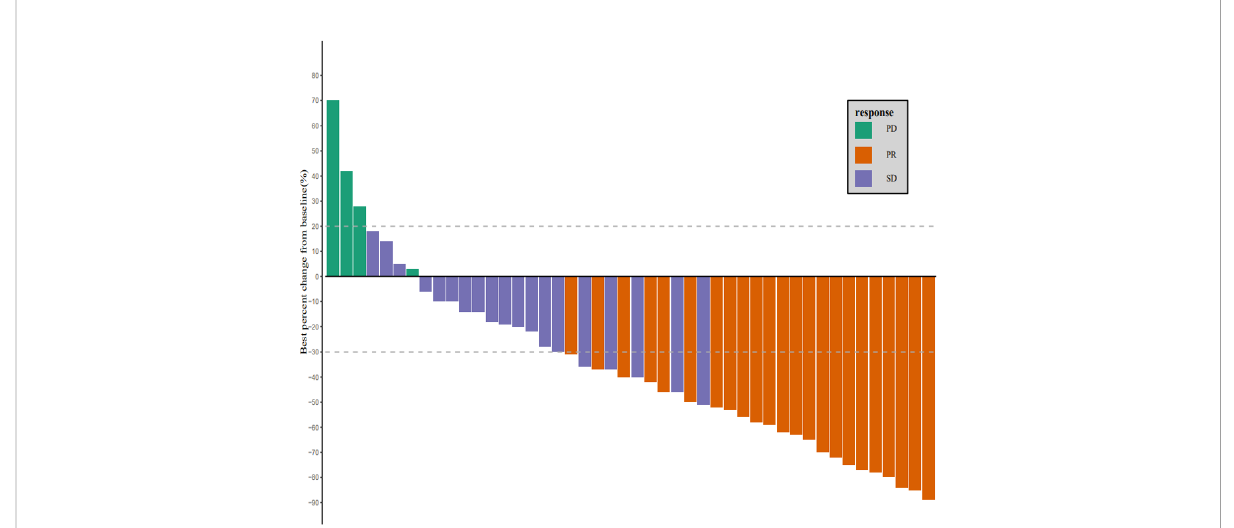
FIGURE 2 Waterfall plots of best changes in the size of the target lesion versus baseline.